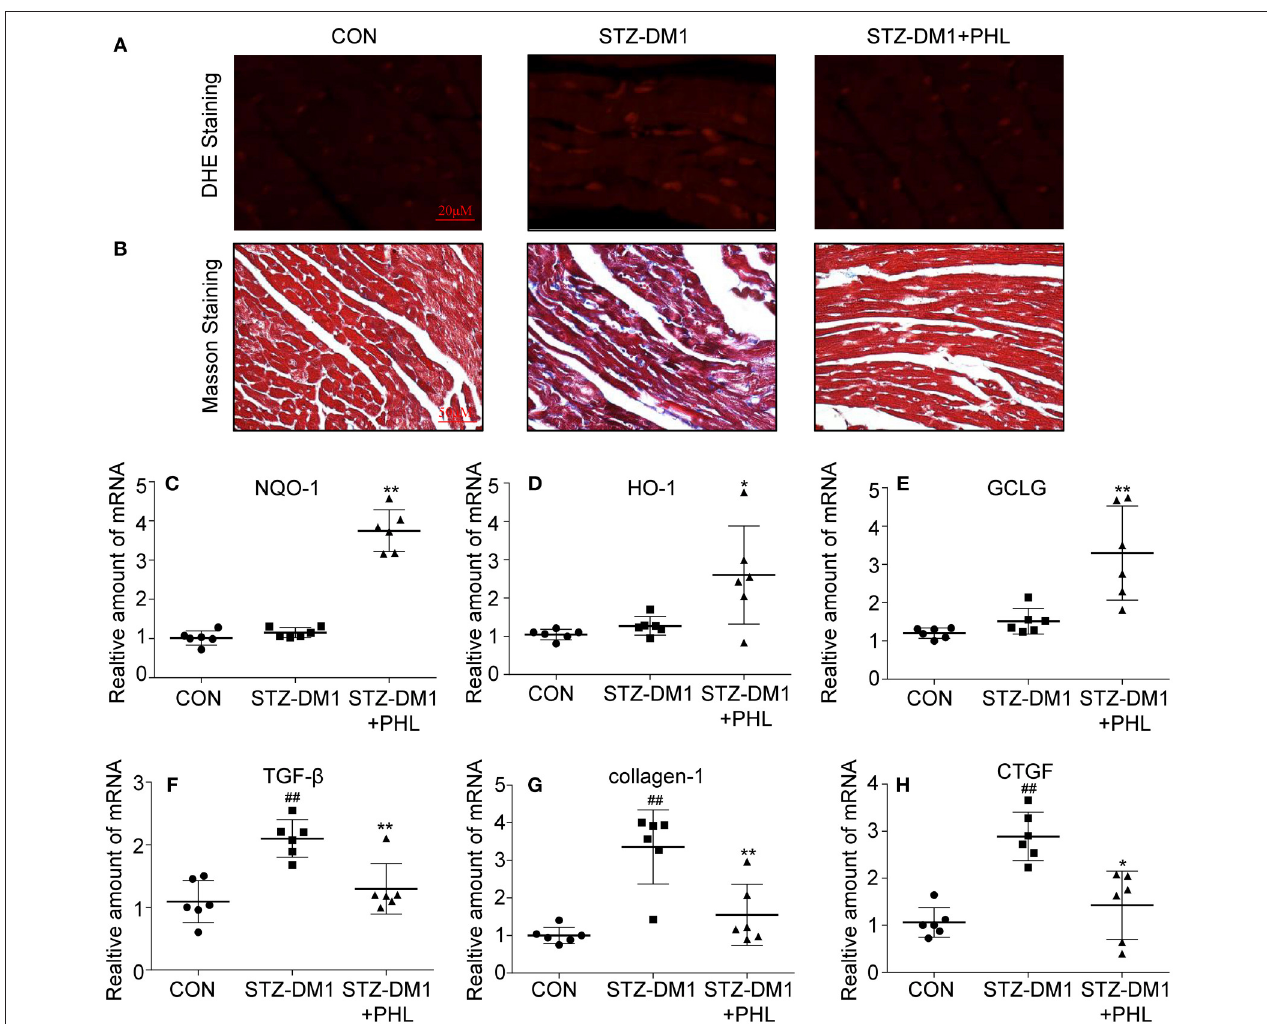
FIGURE 5 | PHL inhibited cardiac oxidative stress and fibrosis in the diabetic myocardium. (A) Representative images for DHE staining using the frozen section of heart tissues as described in Materials and Methods (1000 × magnification). (B) Assessment of cardiac fibrosis by Masson’s Trichrome staining (400 × magnification). (C–H) The mRNA expression levels of HO-1 (C) , NQO-1 (D) , GCLC (E) , TGF- β (F) , collagen-1 (G), and CTGF (H) in myocardial tissues of each group were determined by real-time qPCR. Six mice in each group were used for above analysis. * P < 0.05, ** P < 0.01 vs. STZ-DM1 group; ## P < 0.01 vs. CON